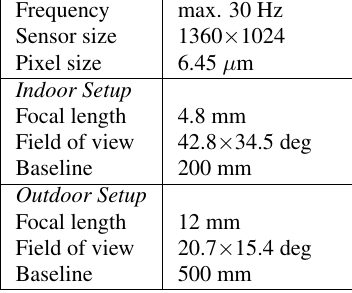
is simply obtained using the C